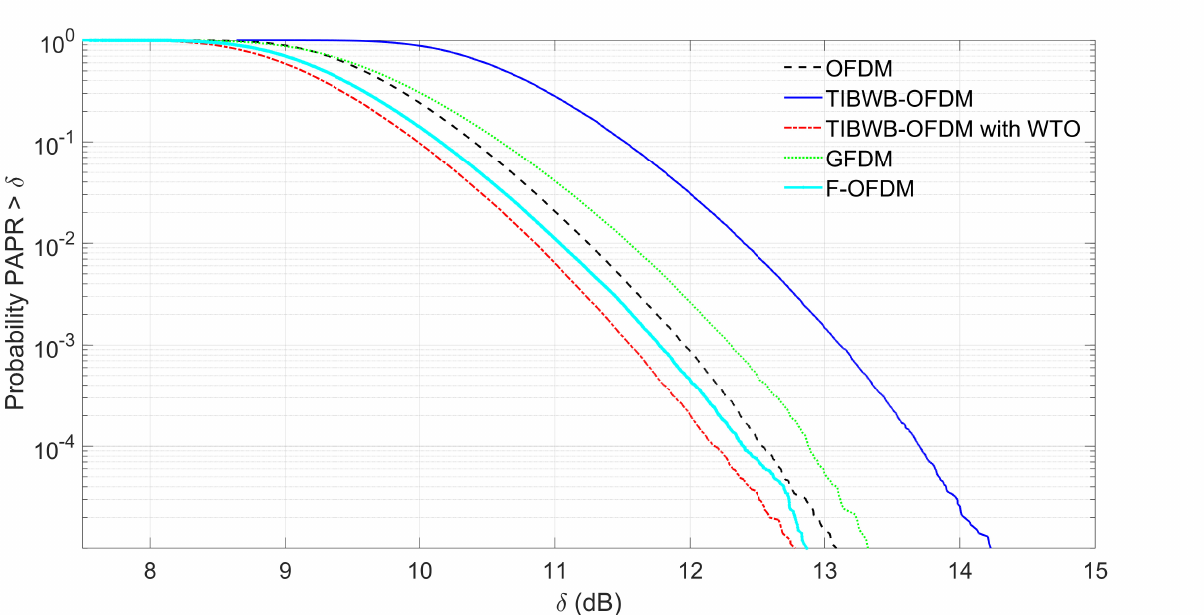
Figure 5. PAPR’s CCDF of the OFDM, TIBWB-OFDM with and without WTO, GFDM and